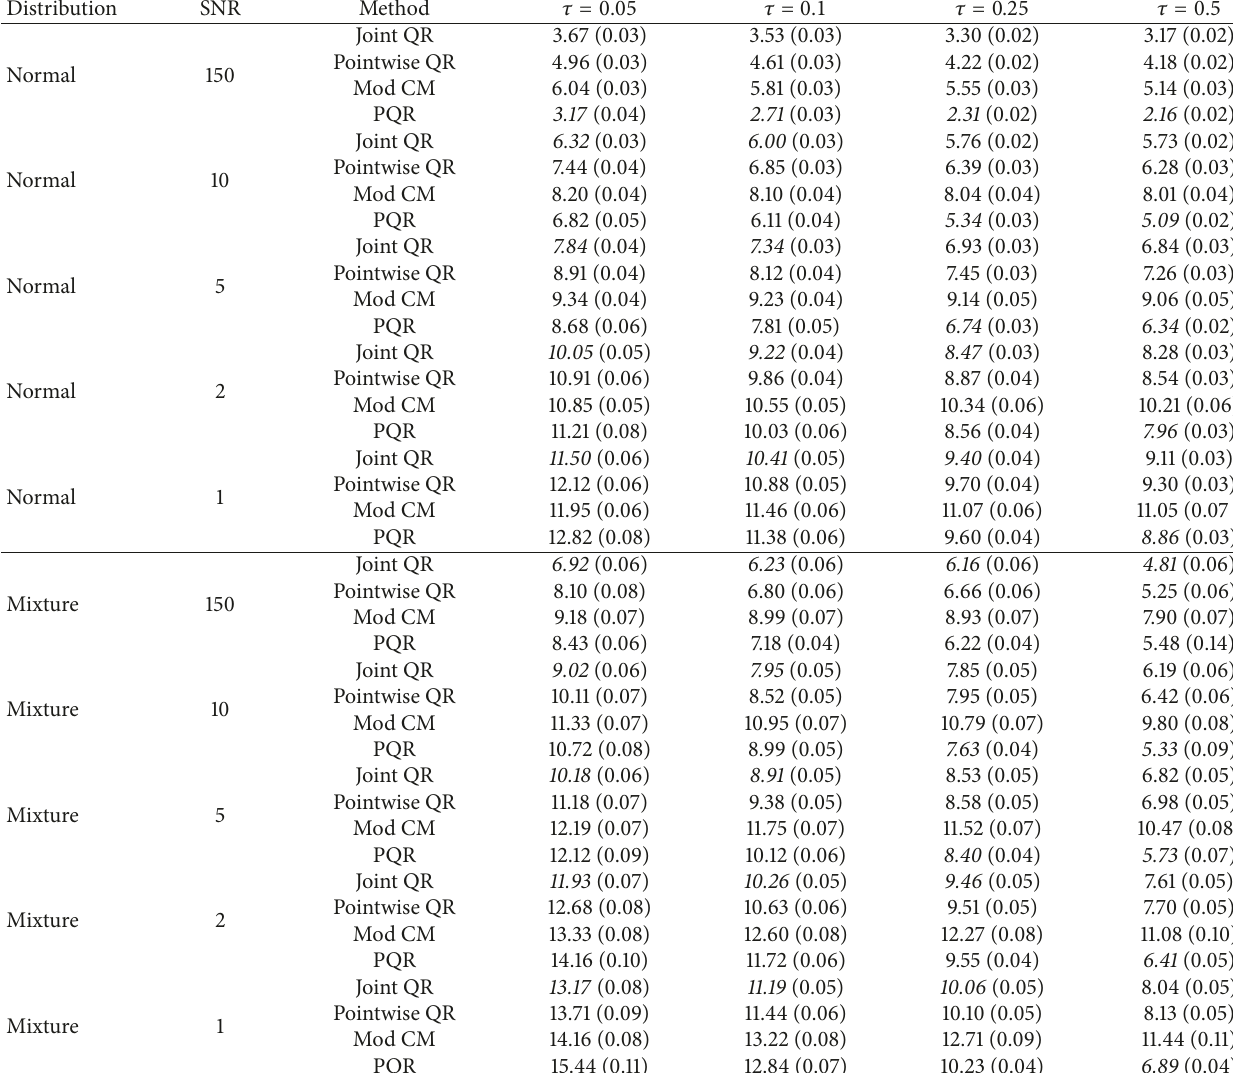
Table 1: Average MAE (standard error in parentheses) of the predicted 𝜏 -level quantile for the case of having a scalar covariate and a sparsely observed functional covariate. Sample size 𝑛 = 100